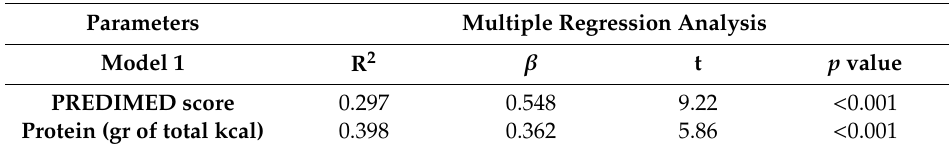
Figure 1. Correlation between PREDIMED (PREvention with MEDiterranean Diet) score and GH peak ( a ) and IGF-1 SDS ( b ). Growth hormone (GH); insulin-like growth factor I (IGF-1); standards deviations scores (SDS). Table 8. Multiple regression analysis models (stepwise method) with GH Peak response (µg/L) as dependent variable to estimate the predictive value of: nutritional parameters (model 1); fatty liver index and BIA parameters (model 2).